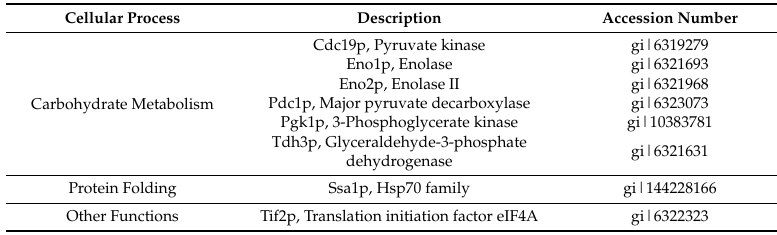
Table 2. Extracellular proteins of S. cerevisiae commonly detected by four independent analysis